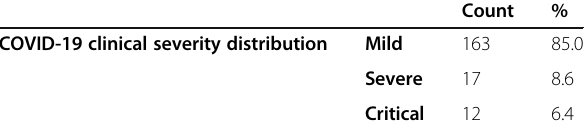
Table 1 COVID-19 clinical severity distribution